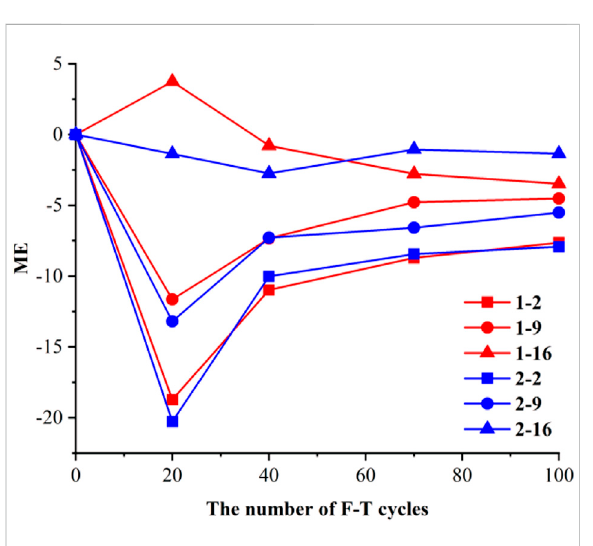
FIGURE 7 ME values for different scanning layers of granite under different numbers of F – T cycles.